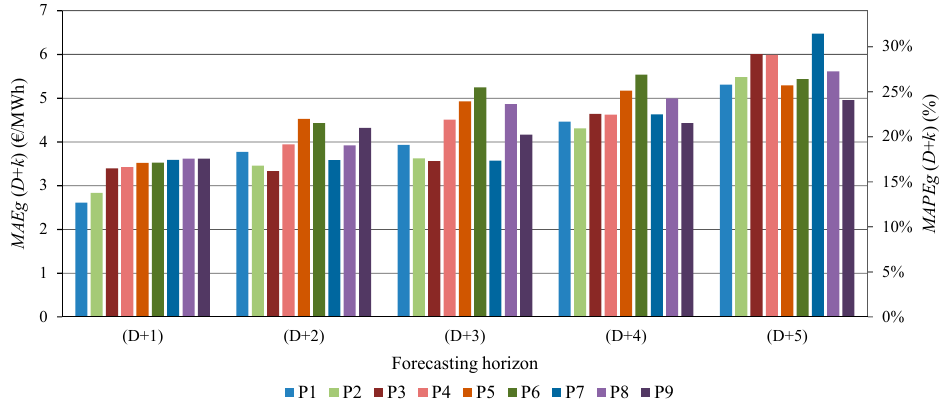
Figure 8. Values of MAE g ( D + 1) to MAE g ( D + 5), and MAPE g ( D + 1) to MAPE g ( D + 5), for predictors P1 to P9.